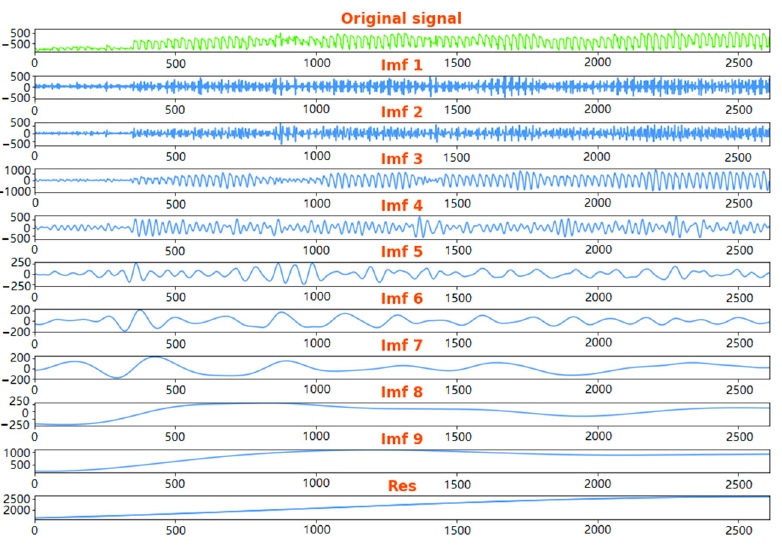
Figure 3. Decomposition result of EEMD.